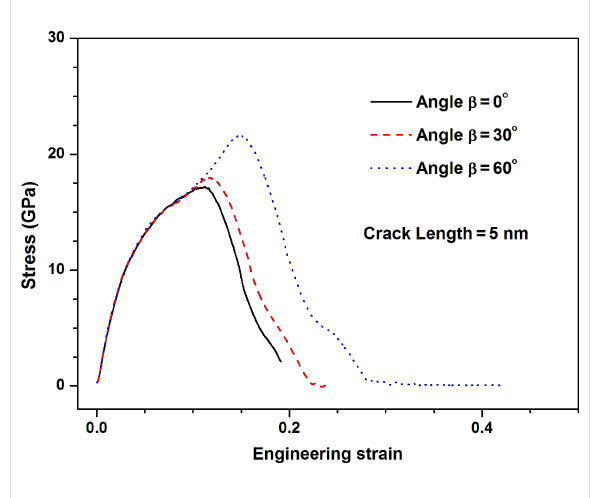
Figure 13: The stress–strain curves along armchair direction of MoS 2 sheet with different crack angles: β = 0°; β = 30°; β = 60°.